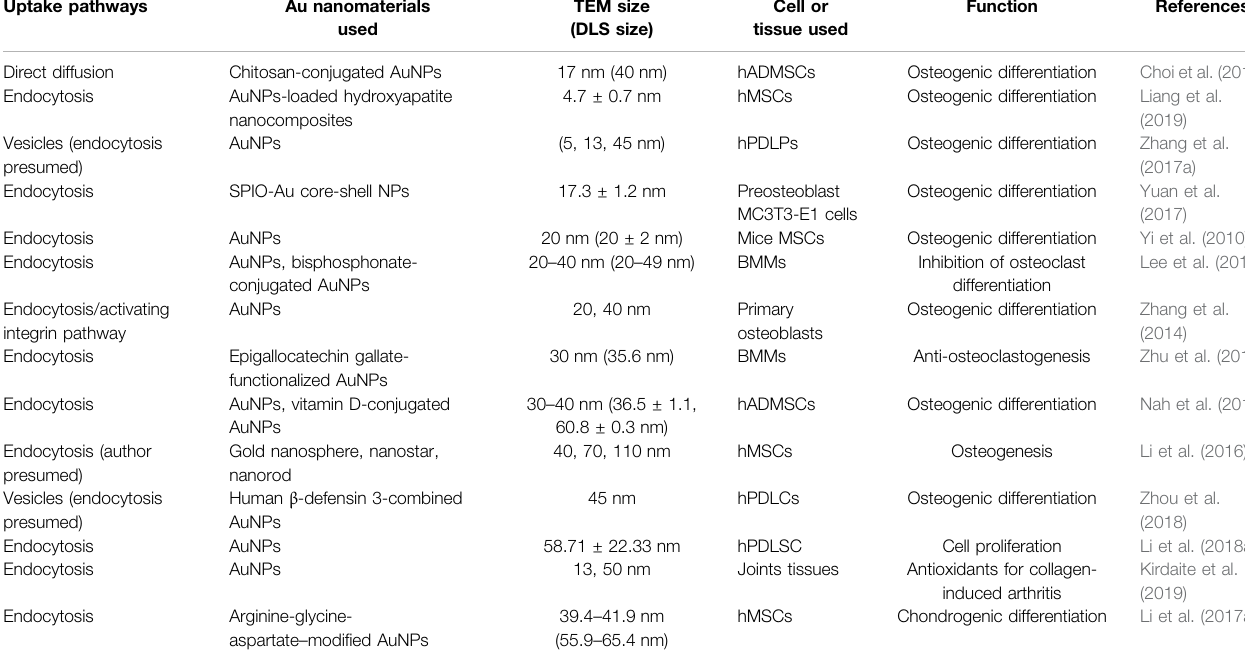
TABLE 1 | The main cellular uptake processes of gold nanomaterials in bone and cartilage tissue engineering. Uptake